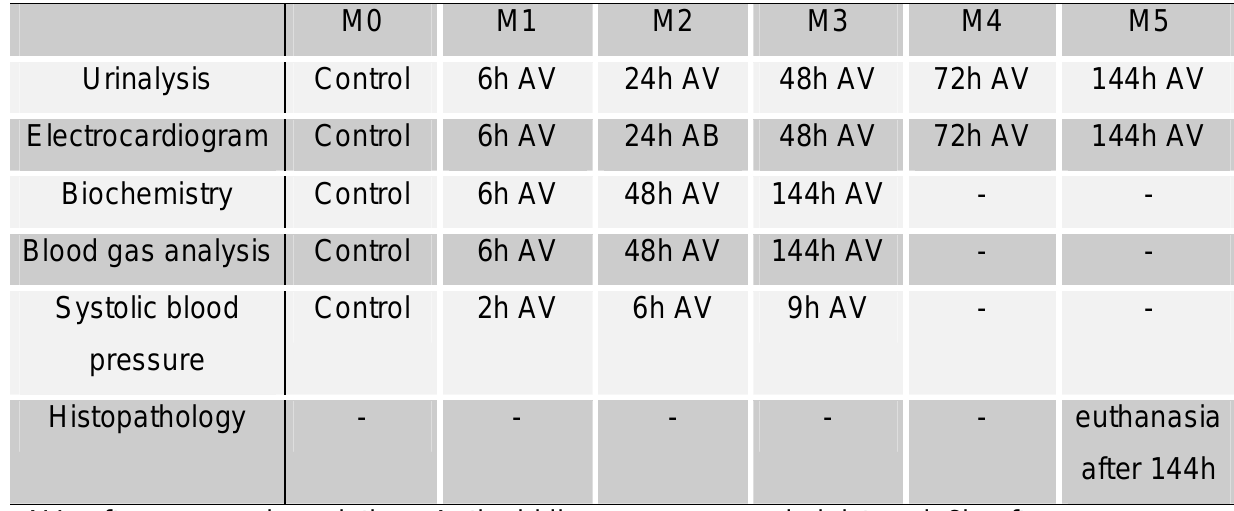
Table 1. Moments (M) of laboratory tests – urinalysis, electrocardiogram, serum biochemistry, blood gas analysis, systolic blood pressure and